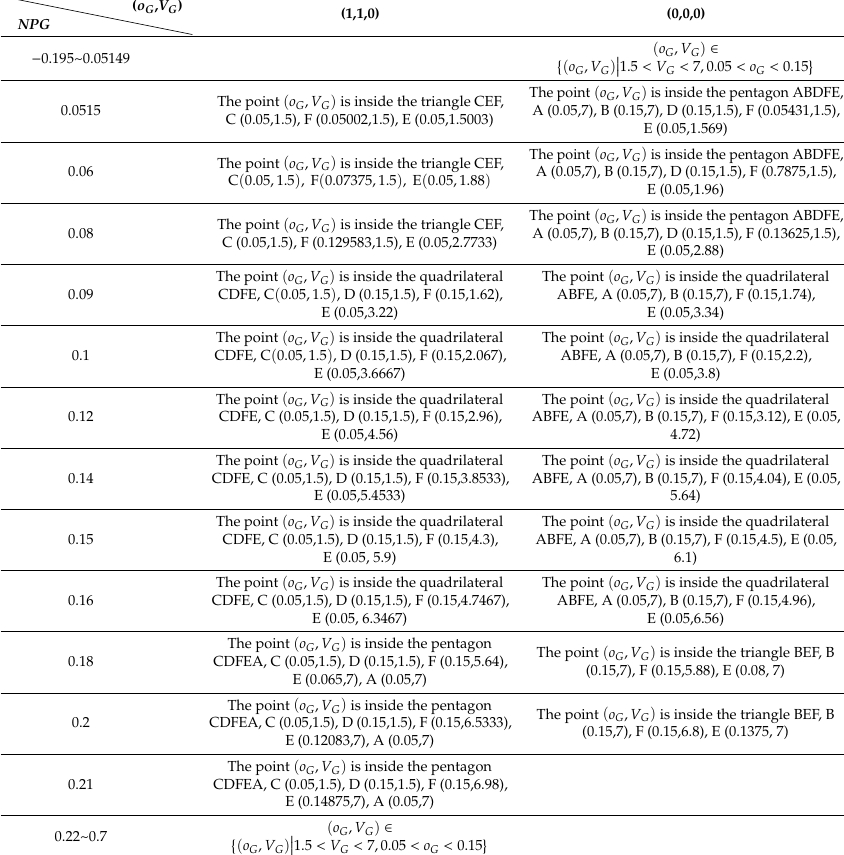
Table A5. Influence of NPG on the energy storage cost decisions of power grid